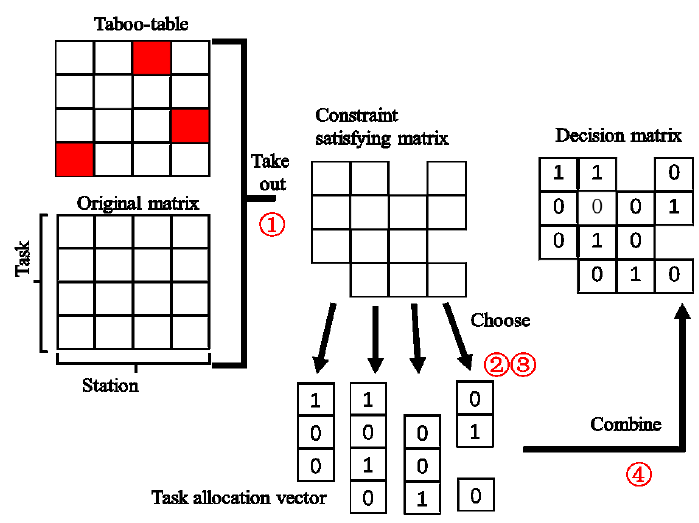
Figure 4. Procedure for constraint-proof initialization (CI).